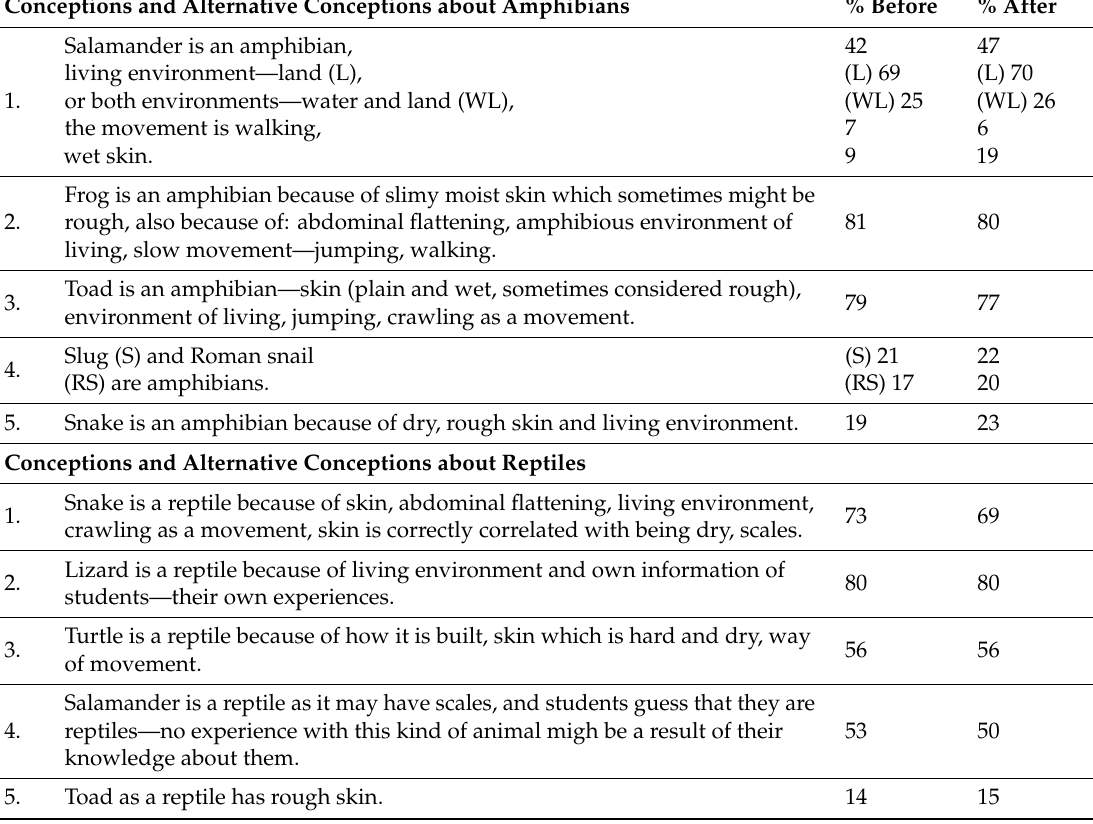
Table 7. Examples of conceptions and alternative conceptions which arise from questionnaires after